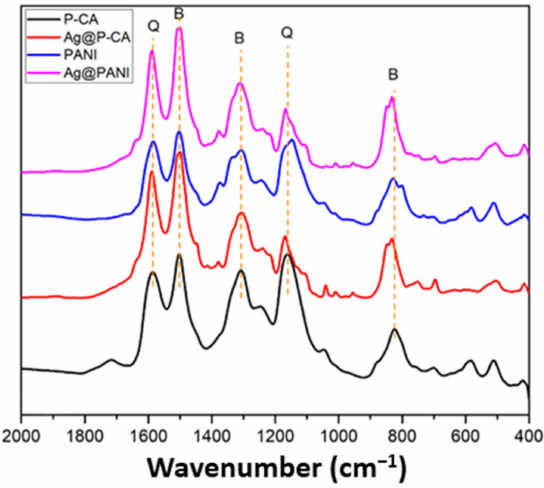
Figure 4. FTIR spectra of PANI-based composites. Orange lines represent characteristic peaks of PANI. Q and B represent the peaks assigned to quinoid (Q) and benzenoid (B) units, respectively.